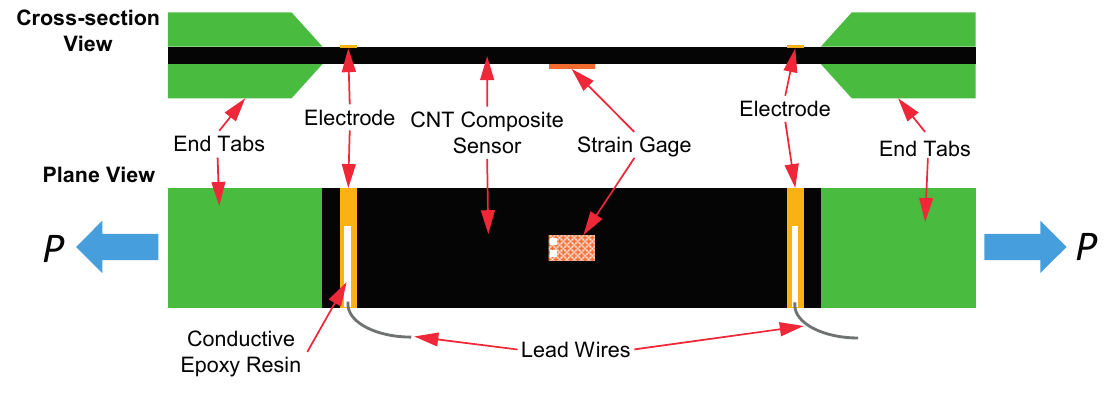
Figure 3. Schematic diagram of in situ CNT composite sensing specimens subjected to